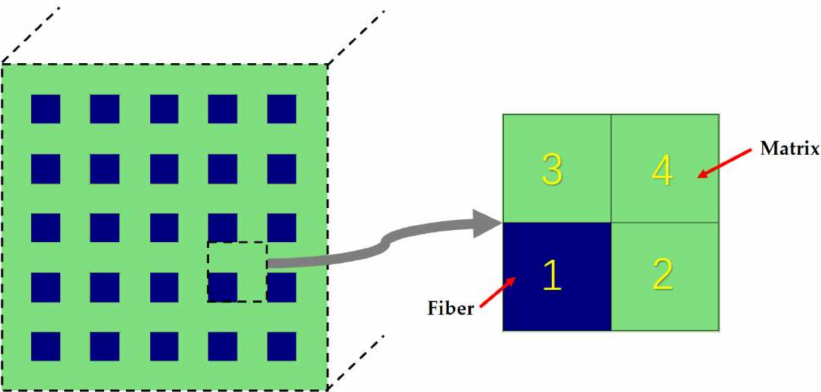
Figure 3. 2 × 2 architecture of the generalized method of cells (GMC) used to represent the compos- ite material.